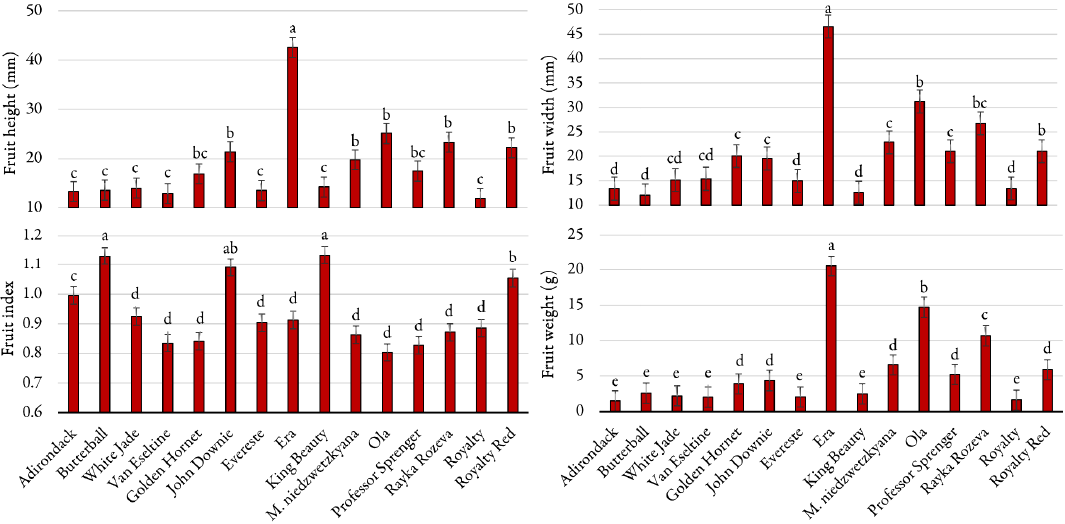
Figure 2. The main fruit characteristics of the 15 cultivars of ornamental crabapples